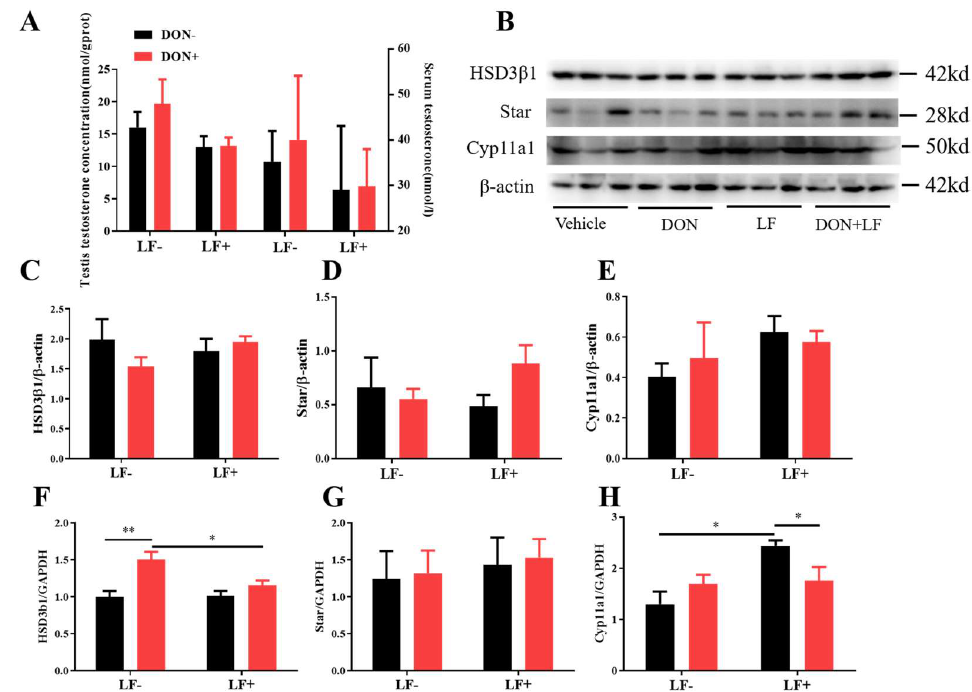
Figure 3. Effects of dietary DON and oral administration of LF on the serum and testicular testos- terone concentrations and expressions of steroidogenic genes in the testis. ( A ) Testosterone concentra- tions in serum and testis; ( B – E ) Immunoblotting of HSD3 β 1, Star, and Cyp11a1 protein expression normalized to β -actin levels and quantification of relative protein density. ( F – H ) Relative mRNA expression of steroidogenic genes HSD3 β 1, Star, and Cyp11a1, normalized to GAPDH expression. Data are expressed as mean ± SEM. For one-way ANOVA, * p < 0.05 and ** p < 0.01.